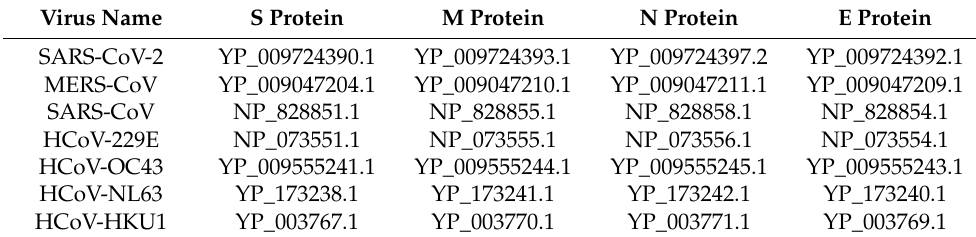
Table 2. The Accession number of reference protein sequence from